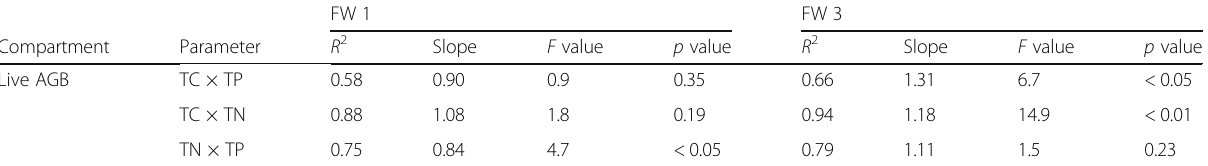
Table 4 Live above ground biomass (AGB) nutrient concentration standardized major axis regression results for flow way 1 (FW 1) and FW 3 within Stormwater Treatment Area-2. Stoichiometric comparisons include total carbon to total phosphorus (TC:TP), total carbon to total nitrogen (TC:TN), and total nitrogen to total phosphorus (TN:TP) FW 1 FW